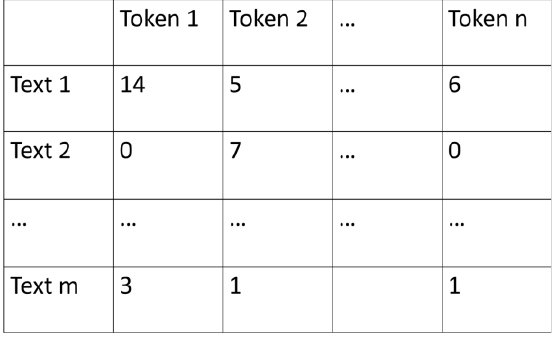
Figure 5. “Bag of words” model .